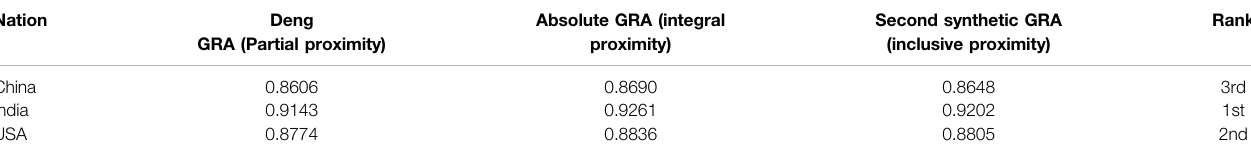
TABLE 3 | Grey relational assessment for GDP per capita and CO 2